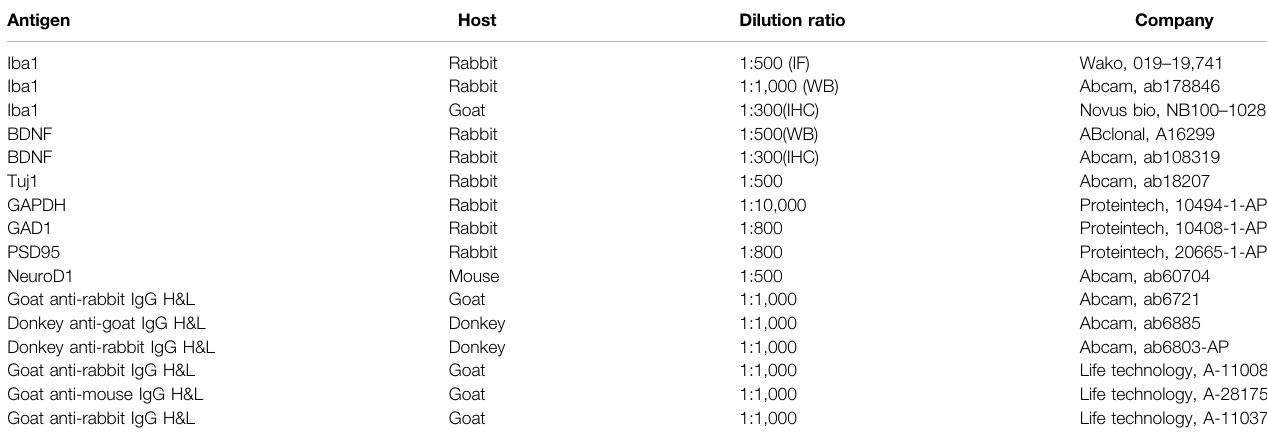
TABLE 1 | Antibodies used in this